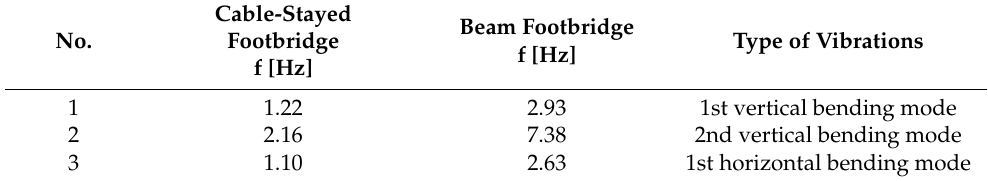
Table 7. Comparison of identified frequencies of the deck’s vibrations.